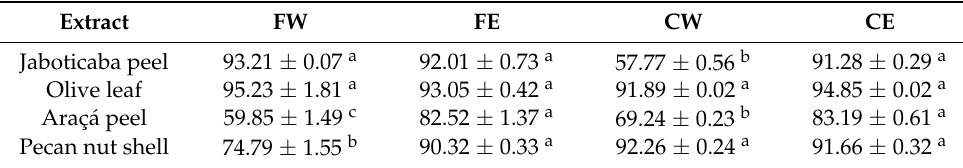
Table 1. RSC DPPH (%, d.w.) natural extracts